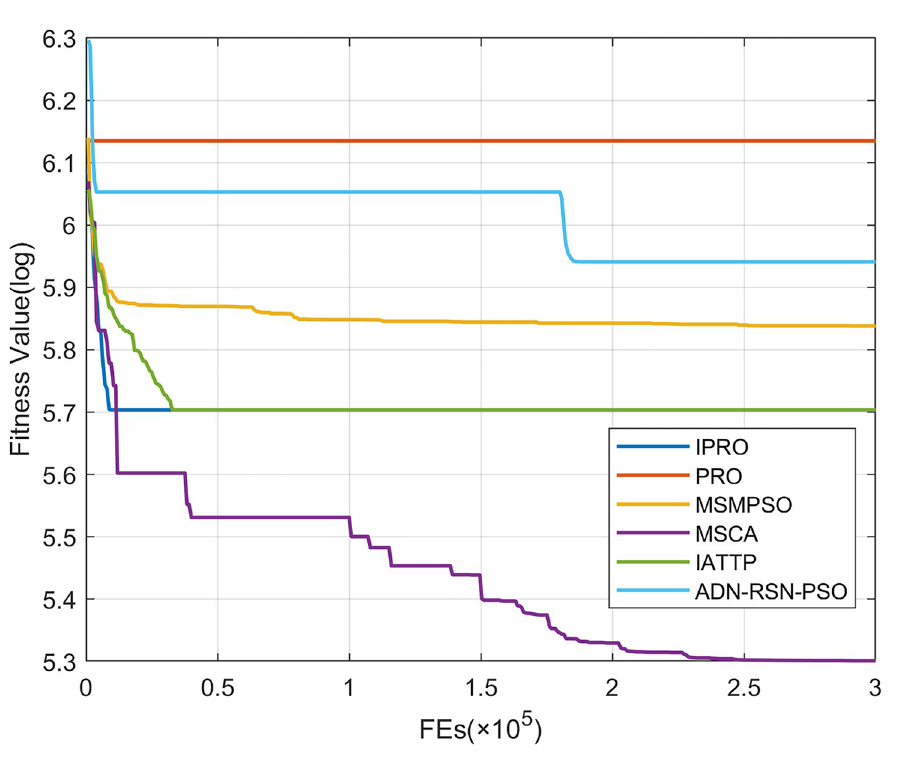
Fig 26. Convergence curves on F26.